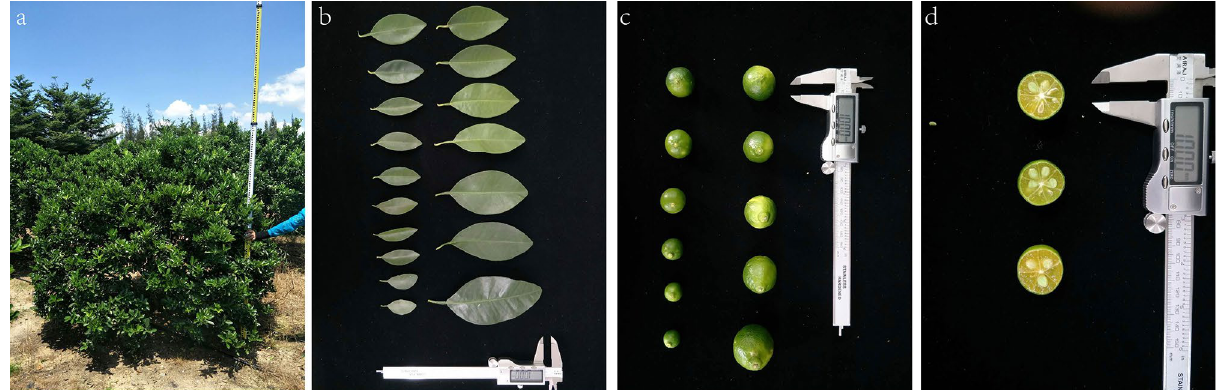
Figure 5. Calamanis ( a Calamanis tree, b Calamanis leaf, c Calamanis fruit size, d Calamanis pulp